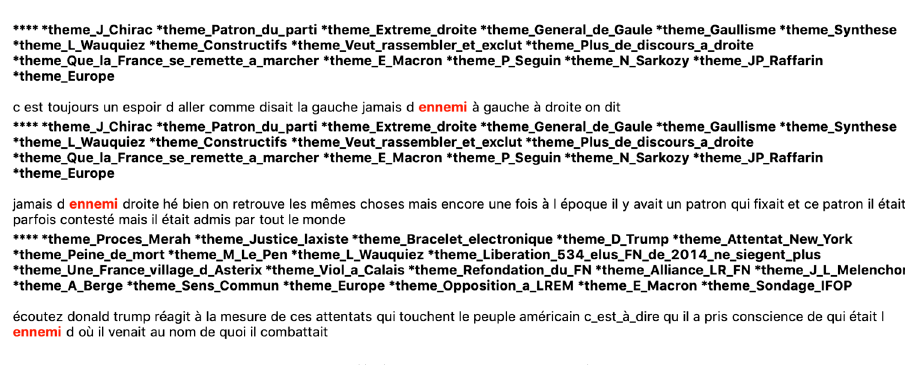
Figure 2. All the text segments with ennemi .